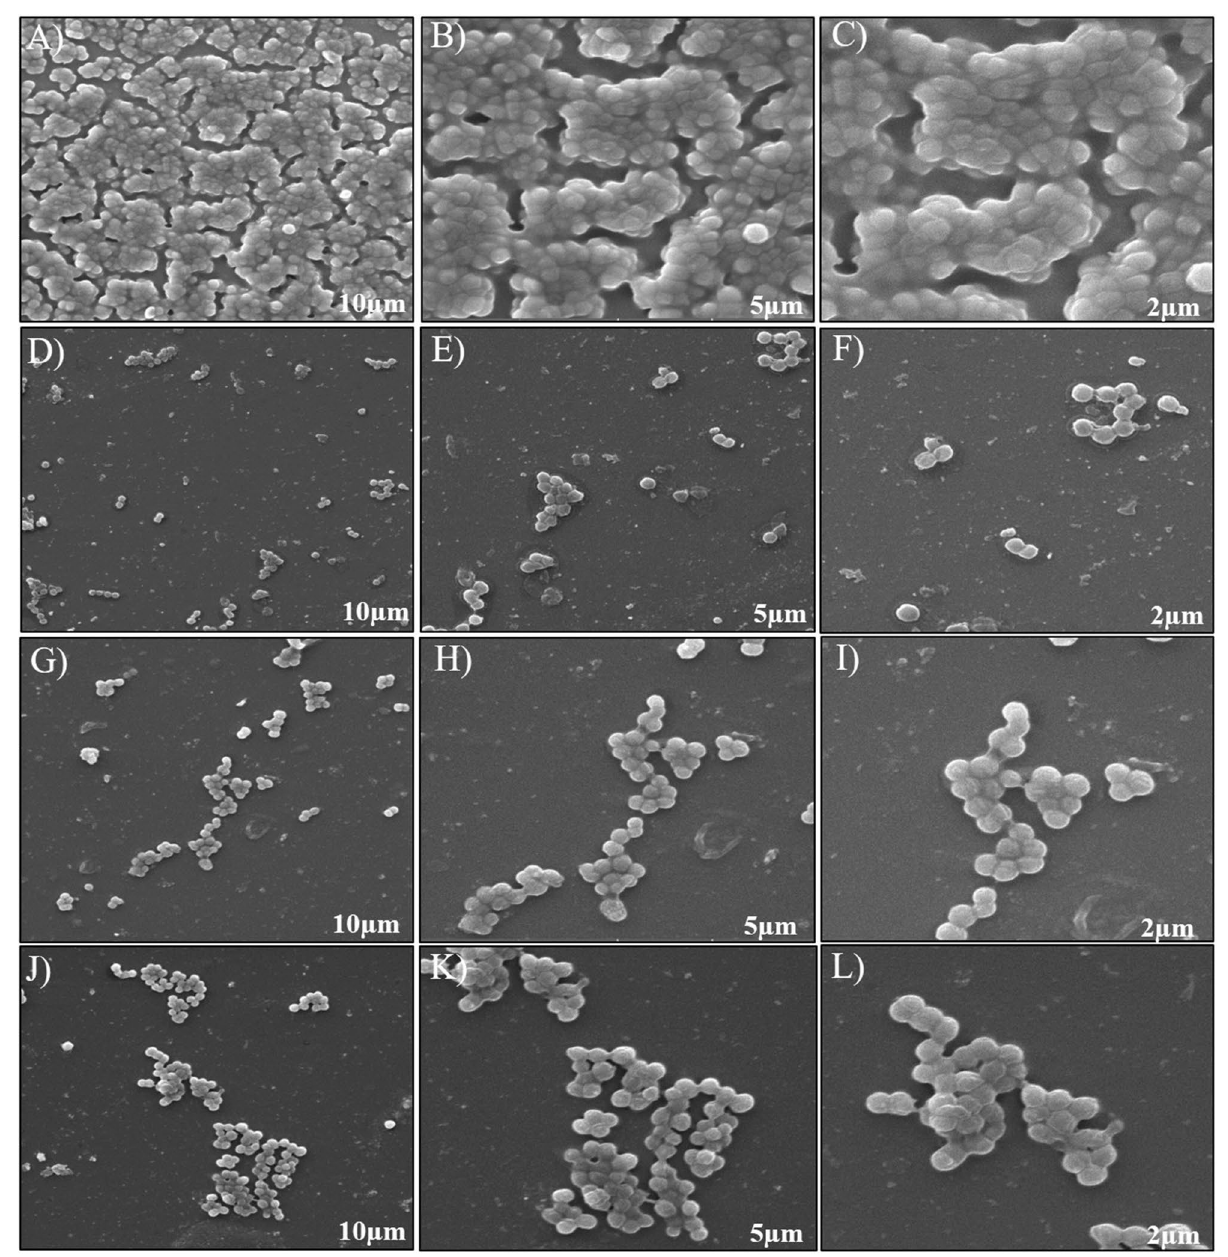
Figure 5. SEM imaging of MRSA biofilm treated with KF@AgNPs and KF@CuNPs. Unhindered colonization of untreated bacteria ( A – C ). KF@CuNPs treated ( D – F ), KF@AgNPs treated ( G – I ), and Doxycycline ( J – L ) treated images. Magnification @10 µm, 5 µm, 2 µm